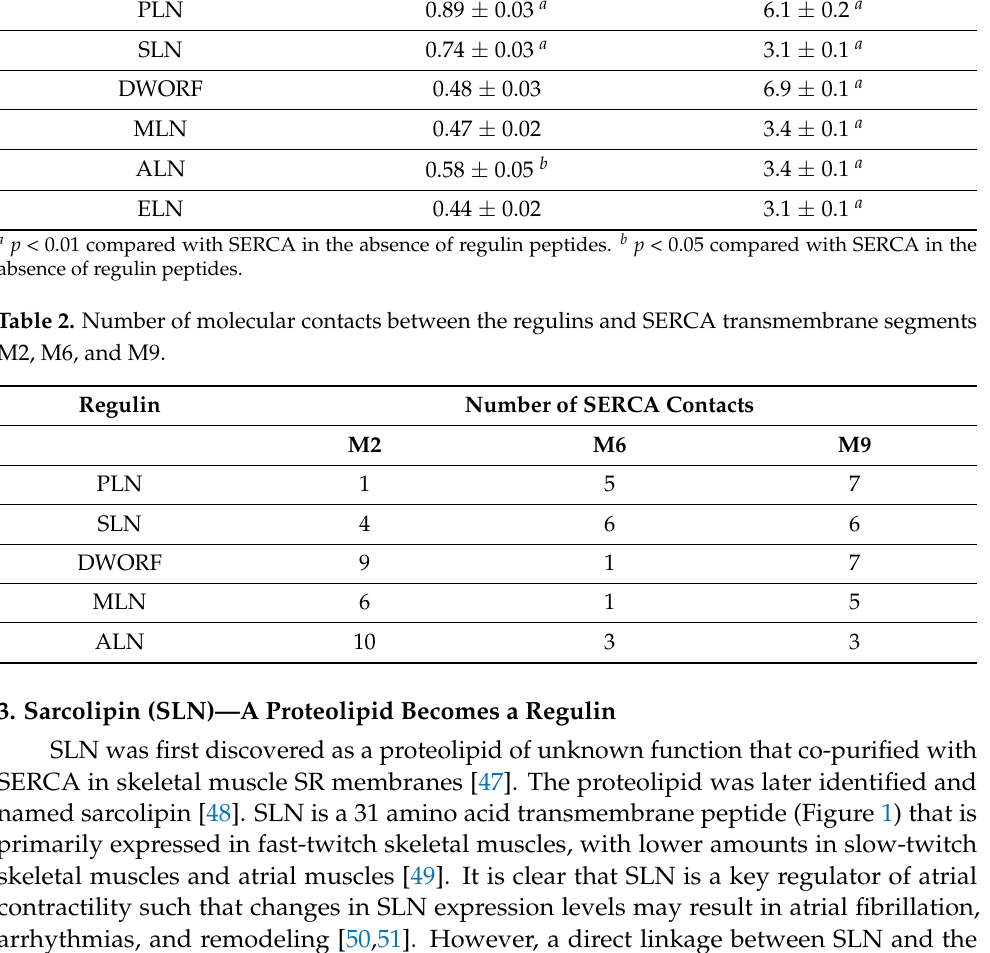
Table 1. Kinetic parameters for SERCA in the absence and presence of regulin peptides. Regulin K Ca ( µ M Calcium) V max ( µ mol/min/mg) SERCA alone